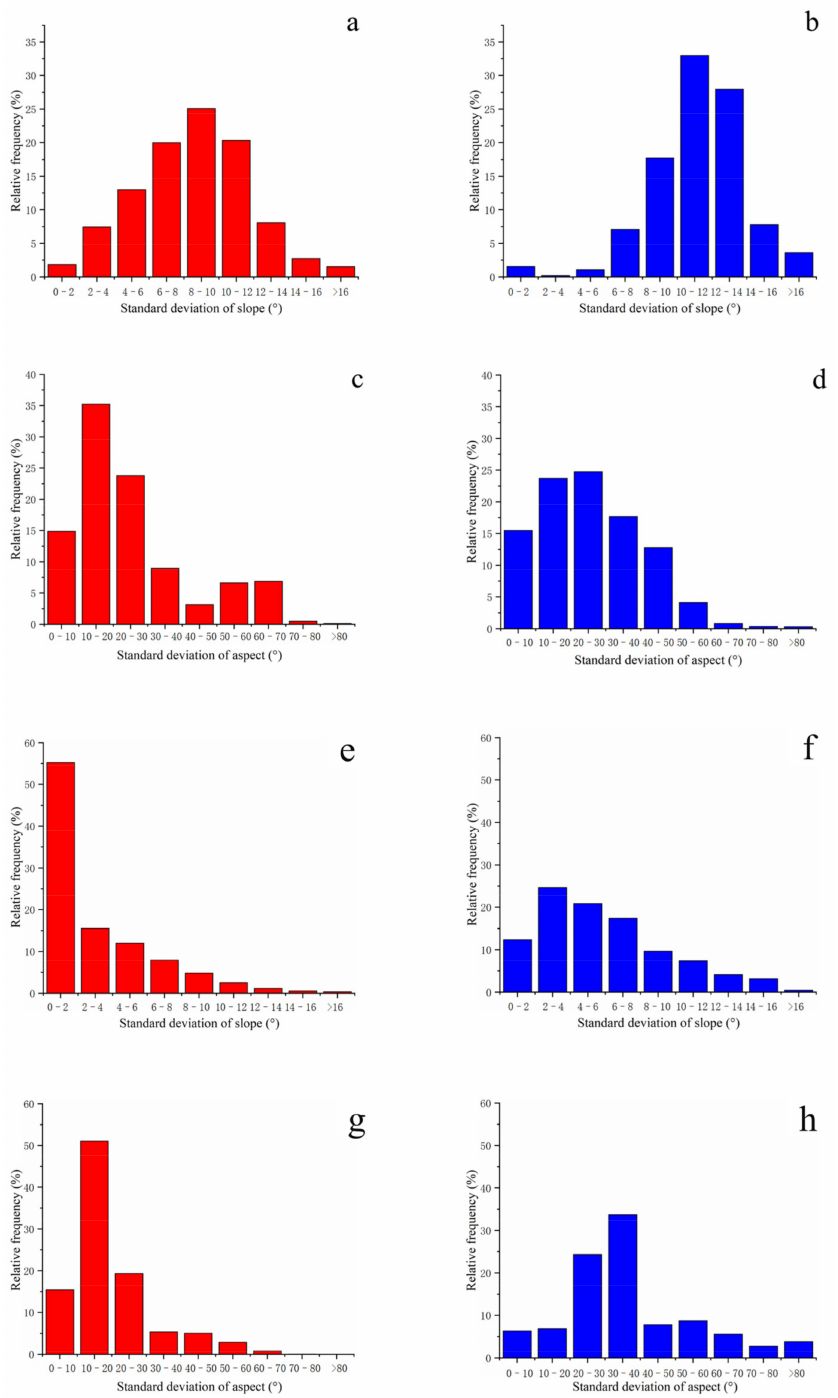
Figure 14. Comparison of slope and aspect standard deviation results: ( a ) slope standard deviation in Jiuyuangou (CTFL method); ( b ) slope standard deviation in Jiuyuangou (hydrological method); ( c ) aspect standard deviation in Jiuyuangou (CTFL method); ( d ) aspect standard deviation in Jiuyuan- gou (hydrological method); ( e ) slope standard deviation in Lushan (CTFL method); ( f ) slope standard deviation in Lushan (hydrological method); ( g ) aspect standard deviation in Lushan (CTFL method); ( h ) aspect standard deviation in Lushan (hydrological